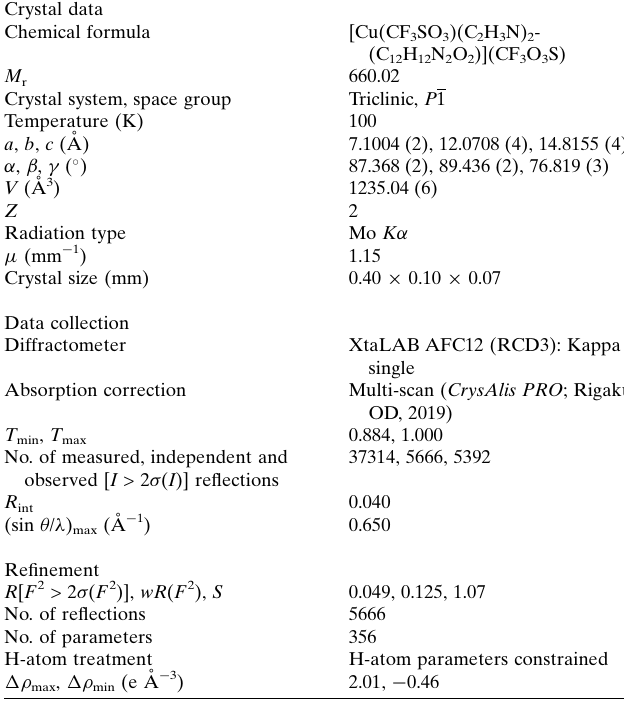
Crystal data Chemical